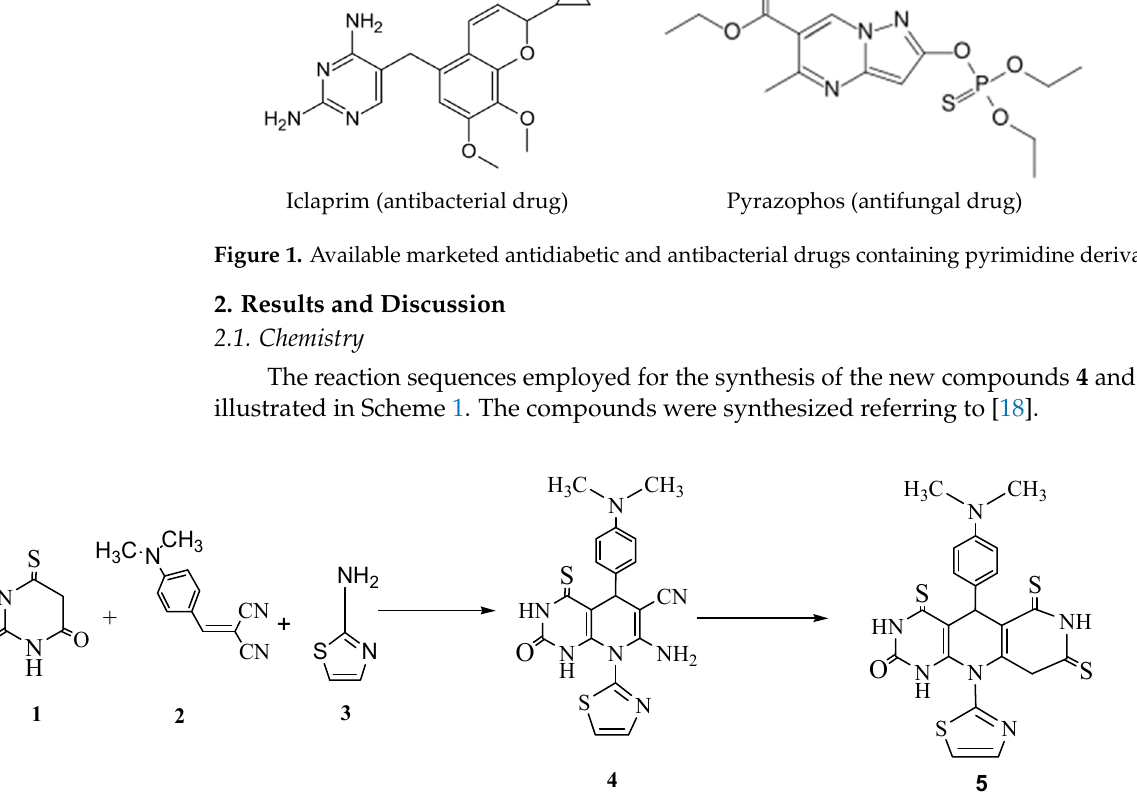
Scheme 1. Synthesis of thiazolopyrimidine derivatives 4 and 5